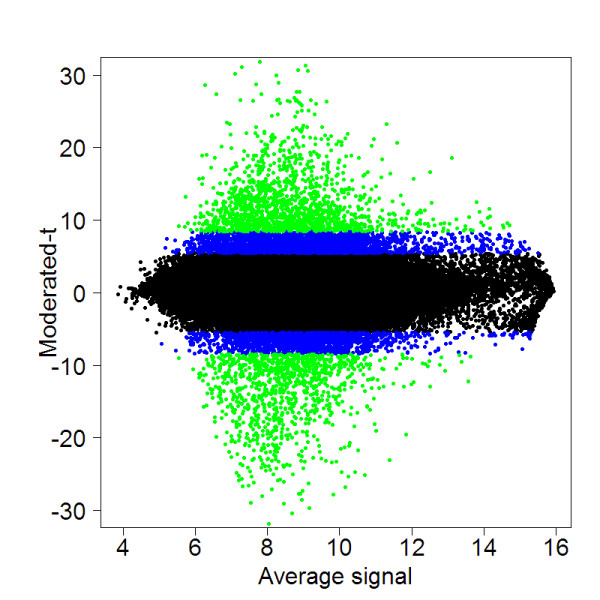
Genetic variation between two melon accessions. A scatter plot of moderated-t vs. average signal of four samples (two different plant DNA pools from each accession), where moderated-t is the Bayesian correction of the t-statistic calculated from the comparison between two 'Dulce' biological replicates and two PI414723 biological replicates. Black dots are statistically insignificant differences, i.e., non-SFPs, and blue (adjusted-p < 0.05) and green (B ≥ 1.5) dots are statistically significant differences, i.e., putative SFPs.